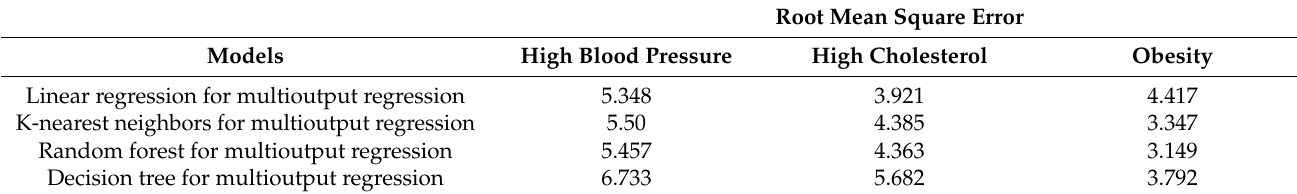
Table 5. Root mean square error (RMSE) values of k-nearest neighbors, random forest, and decision tree for multioutput regression.